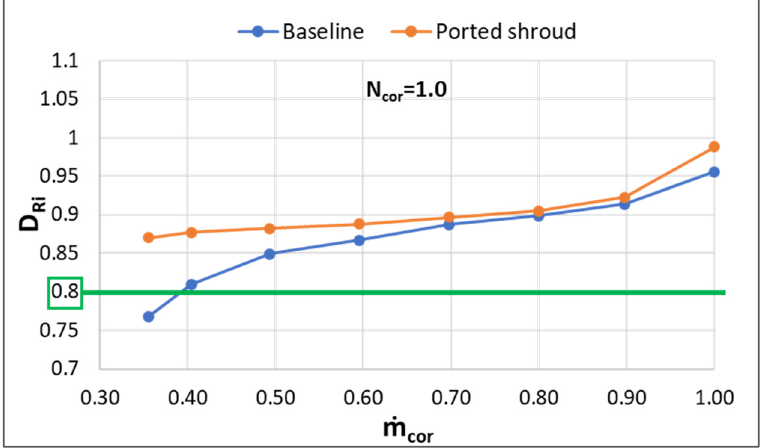
Figure 19. Variation in the diffusion ratio D Ri with mass flow rate in the configurations with ported shroud and baseline, at N cor =